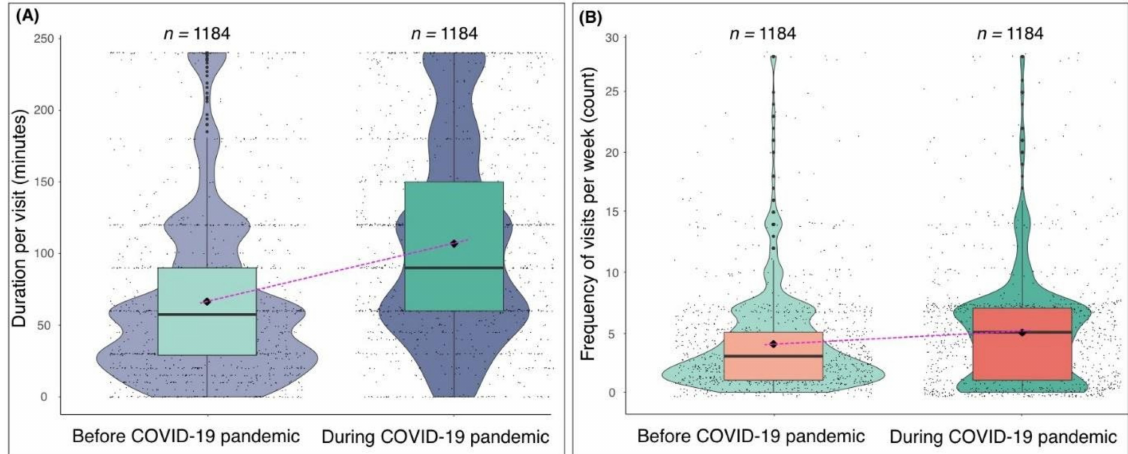
Figure 3. Violin plots ( A ) typical duration spent in natural environments (e.g., parks, woodland) before ( left ) and during ( right ) the COVID-19 pandemic; and ( B ) typical frequency of visits to natural environments per week before ( left ) and during ( right ) the COVID-19 pandemic. The black diamond represents the mean